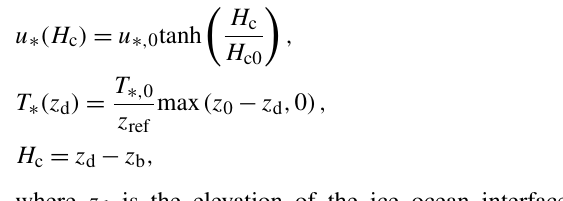
is continuous b